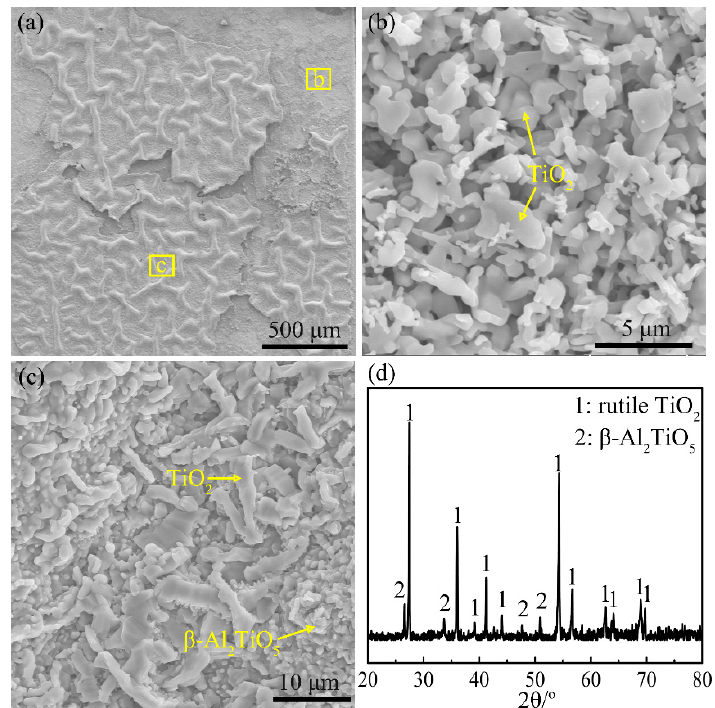
Figure 11. ( a – c ) Surface morphologies and ( d ) XRD pattern of the oxide formed during continuously heating the Ti-24Al-15Nb-1.5Mo alloy to the end of Stage IV.